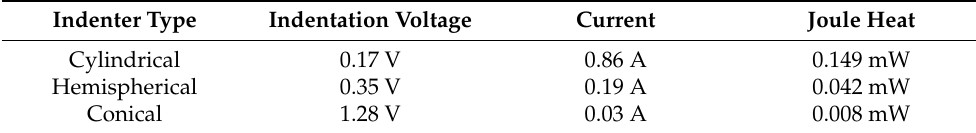
Table 3. Electrical response of a LIB cell under various